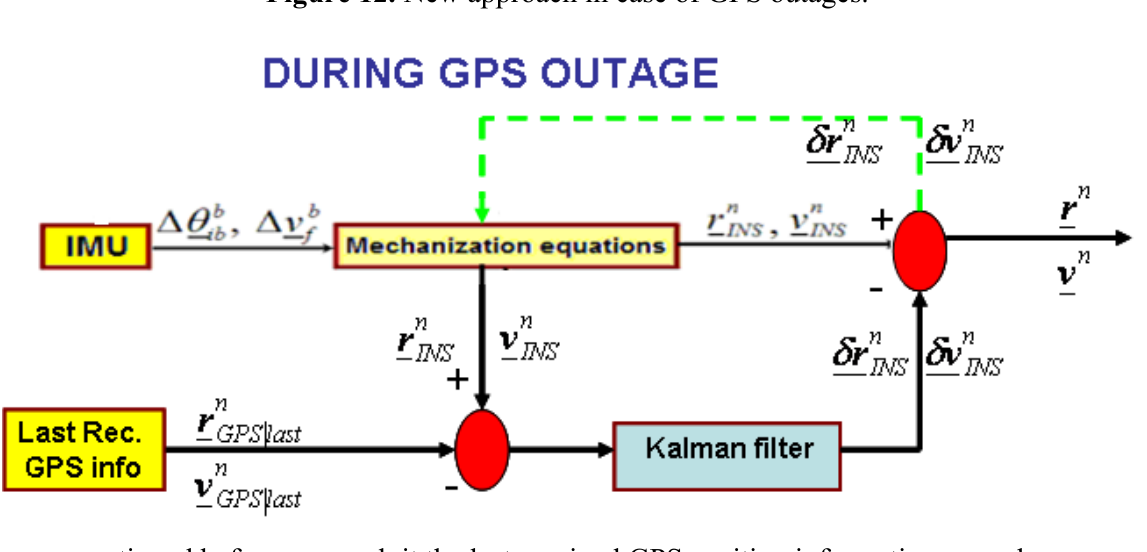
Figure 12. New approach in case of GPS